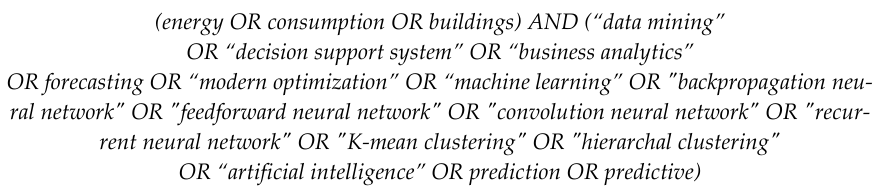
Figure 2. Search query.